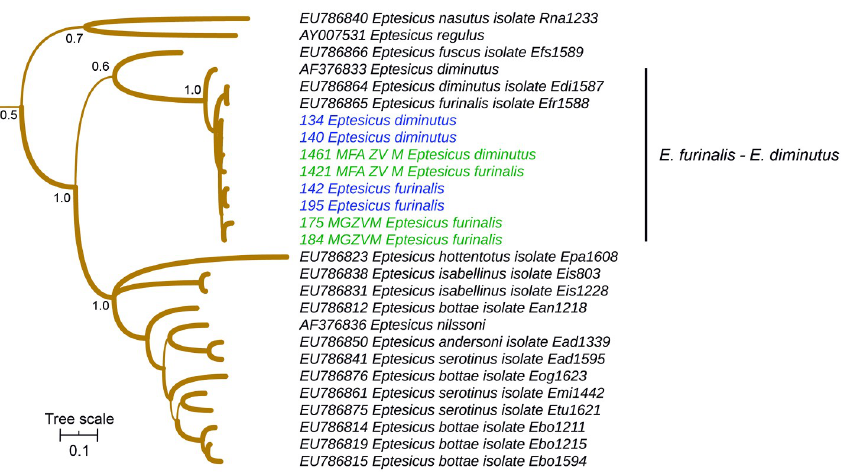
Fig 6. Cytochrome b -based Bayesian phylogeny of Eptesicus . Main clades posterior probability values are annotated. Branch width represents internal node support. Terminal font color indicates sequence source: black indicates sequences retrieved from Genbank, green indicates museum voucher sequences obtained in this study, while blue color indicates samples captured at the field and sequenced in this study. The scale units are substitutions per site.